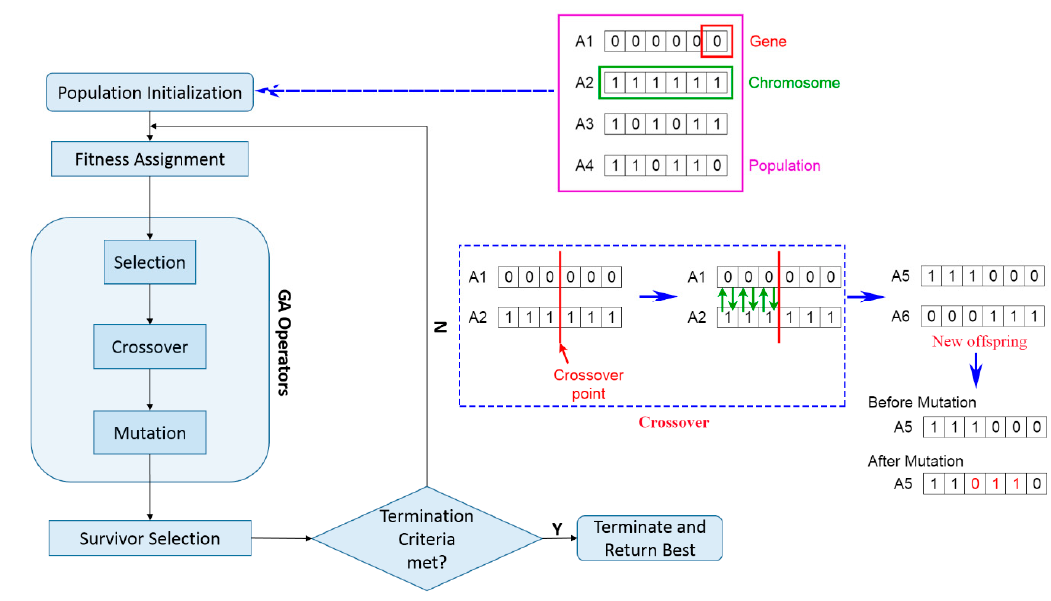
Figure 3. Flow chart of a genetic algorithm (GA).